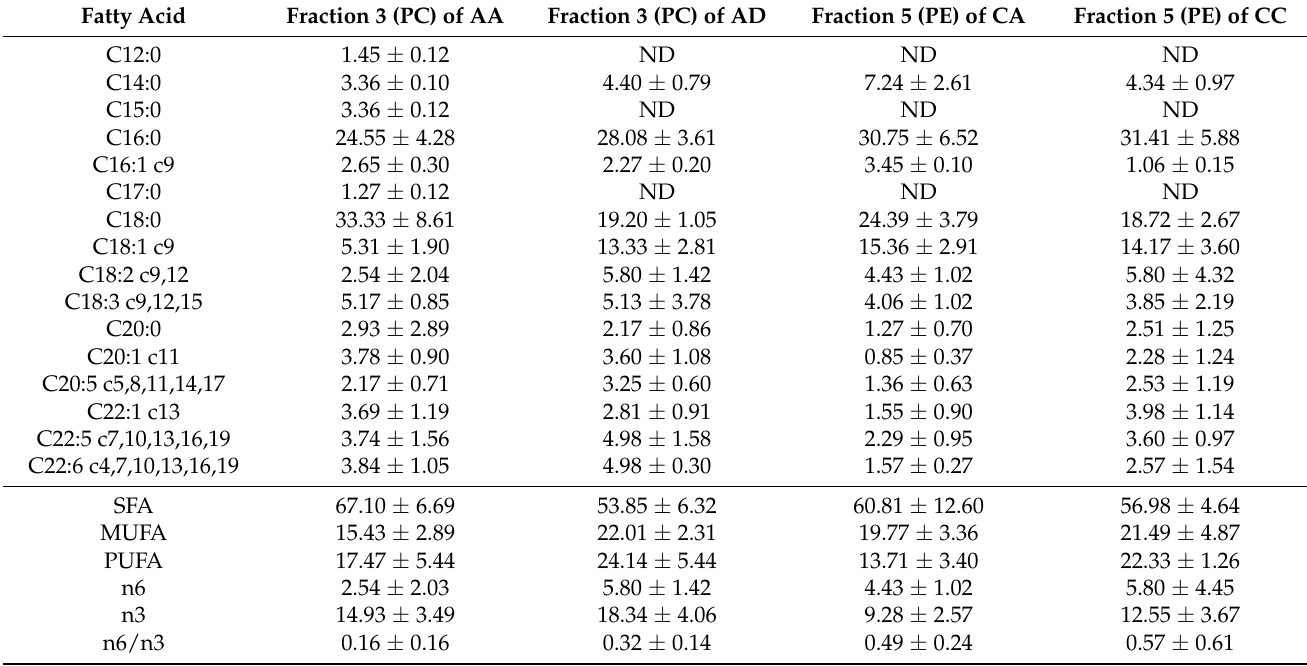
Table 4. The fatty acid profile obtained of the bioactive polar lipid fractions of PC and PE of the apple juice and apple cider samples expressed as the percentage of each fatty acid in the total fatty acids for each sample (mean ± SD, n =